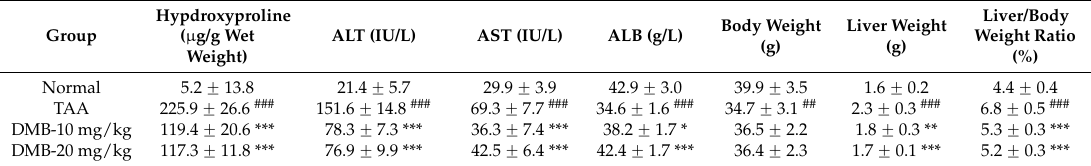
Table 4. Effects of DMB on Hypdroxyproline, serum ALT, AST, ALB and liver-to-body weight ratio serum in mice with TAA-induced liver fibrosis.